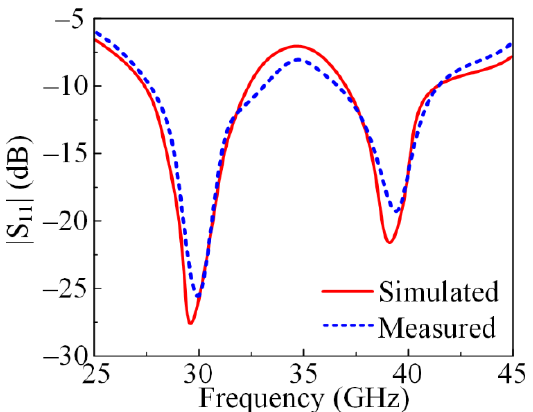
Figure 3. S-parameter plot of a proposed dual-band antenna operating at 28 GHz and 38 GHz, measured and simulated.